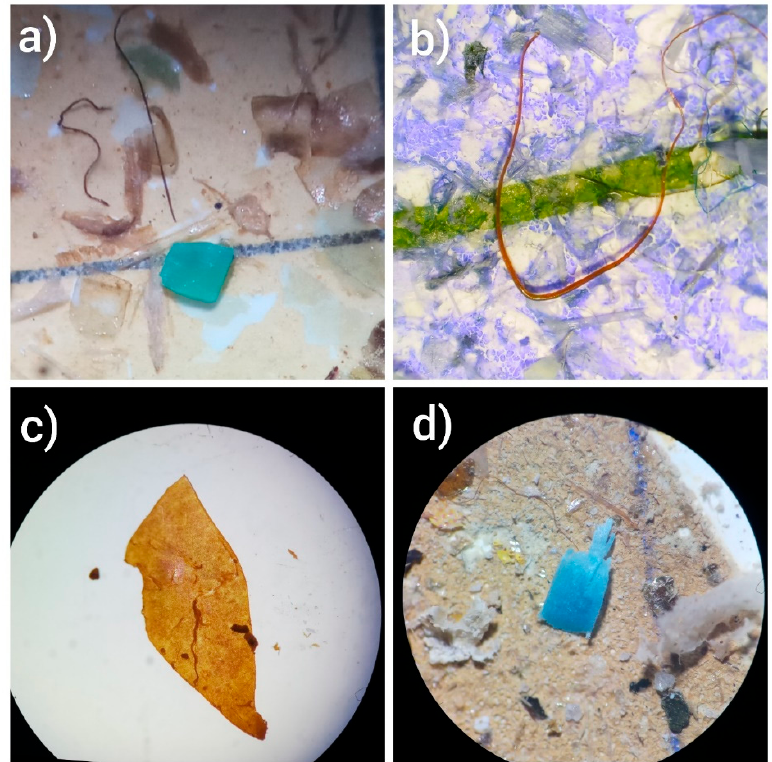
Figure 2. Microscopic images of some of the extracted MPs representing different particle shape, ( a , d ) fragments, ( b ) fiber, and ( c ) sheet. Table 1. Relative abundance of different sizes and shapes of MPs recovered.